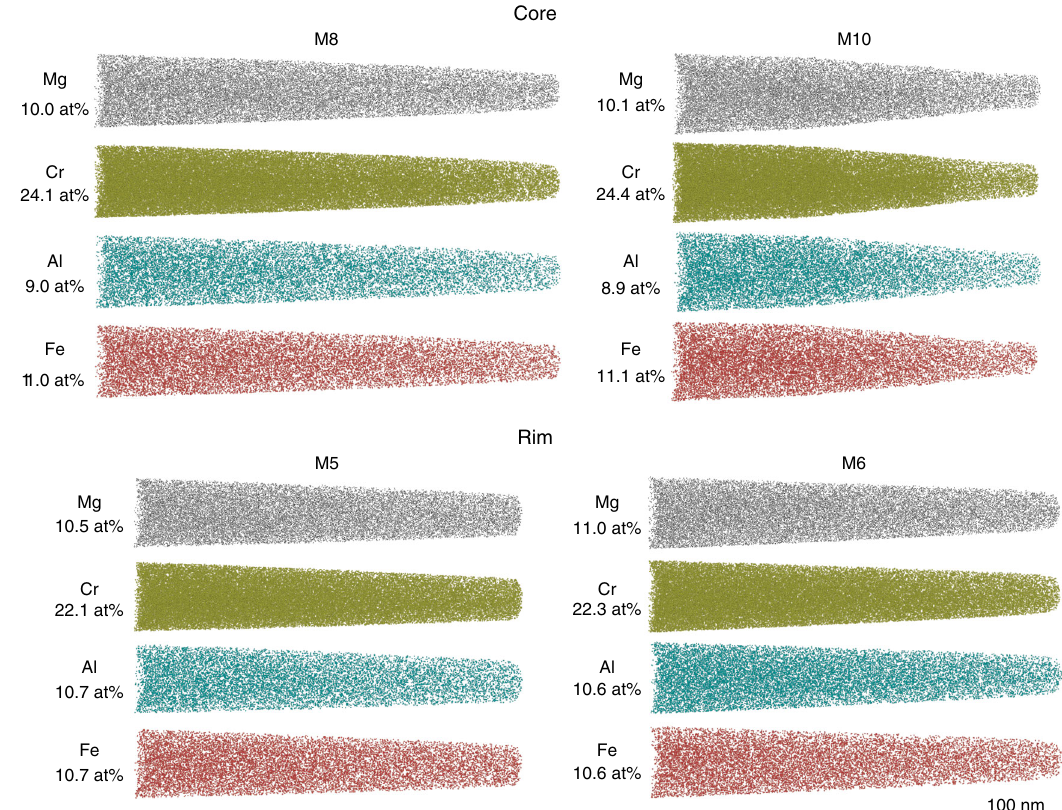
Fig. 5 Atom probe tomography results. Atom maps of Mg, Cr, Al, and Fe are presented for needle-shaped specimens from the core (M8 and M10) and the rim (M5 and M6). The specimens were extracted from sample A4D and their location is indicated on Fig. 1b. The composition in atomic % is indicated for each specimen (See Supplementary Data 2). The composition of the core is enriched in Cr and depleted in Al compared to the